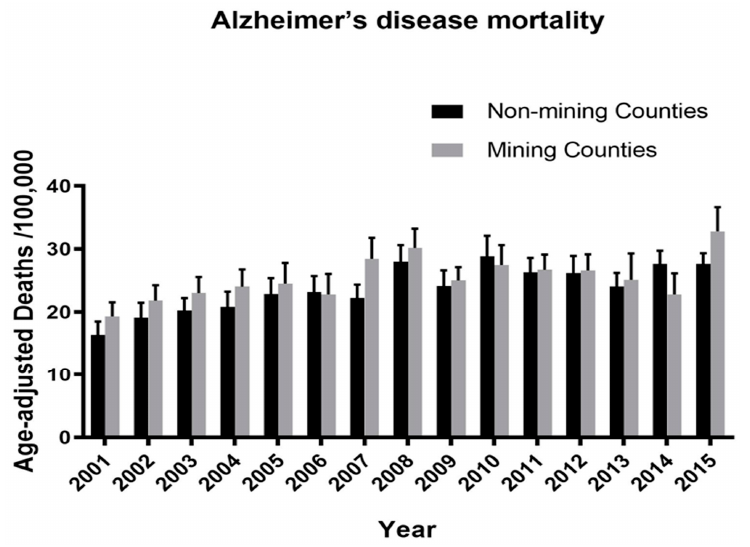
Figure 9. Alzheimer’s disease mortality in MTM vs. non-mining counties in West Virginia over the years spanning 2000–2015. The analysis did not find an effect of MTM on age-adjusted Alzheimer’s disease mortality/100,000 population (F = 0.38; df = 1, 52; p = 0.53). Likewise, there was no interaction between year and mining (F = 0.70; df = 14; 728; p = 0.76). However, similar to the finding for dementia mortality, a significant effect of year (F = 4.34; df = 14, 728; p < 0.0001) was found. Cardiovascular disease vs. dementia: A two-factor repeated measures ANOVA examination of major cardiovascular disease mortality in MTM counties for the years 2001–2015 was undertaken to determine if this might be a confounding factor with respect to the dementia vs. MTM findings. This showed a significant difference (decline) in cardiovascular disease (CVD)-related deaths over this period (Figure 10a; F = 63.25; df = 14, 714; p < 0.0001). Although a possible trend was evident, there was no significant effect of MTM on CVD mortality when analyzed over the 15 year period (F = 2.84; df = 1, 51; p = 0.097). There was no interaction of year and county mining status on CVD mortality (F = 0.64; df = 14, 714; p = 0.82). A Pearson’s r correlation analysis was used to assess a possible relationship between CVD vs. dementia mortalities for the years 2001–2015. A significant negative correlation was found between CVD mortality/100,000 population vs. the mean age-adjusted dementia mortality/100,000 population per year (Figure 10b; r = − 0.935; p < 0.0001; 15 xy pairs).